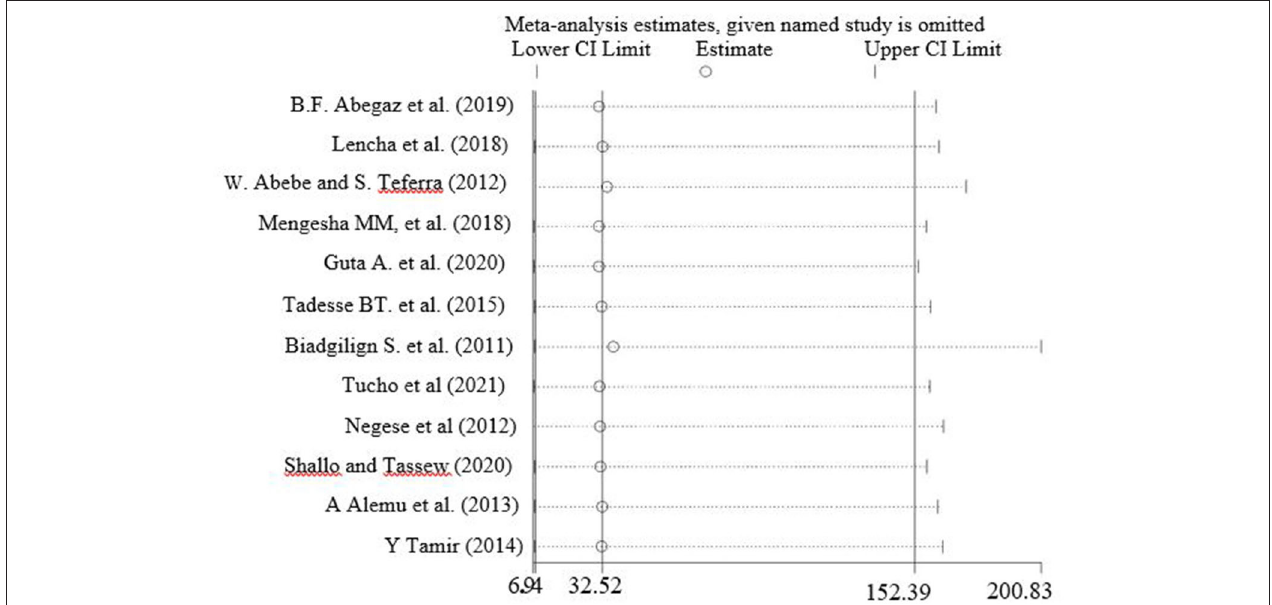
FIGURE 5 | Sensitivity analysis of pooled prevalence for each study being removed one at a time.